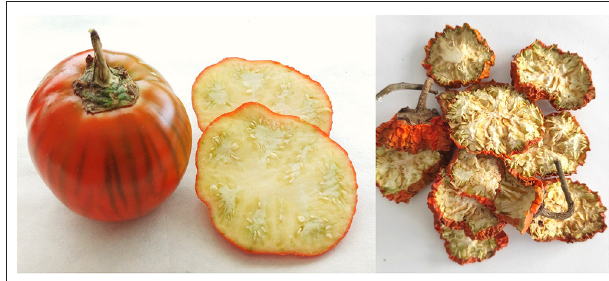
FIGURE 1 | Solanum aethiopicum L . cv. red eggplant from Rotonda,